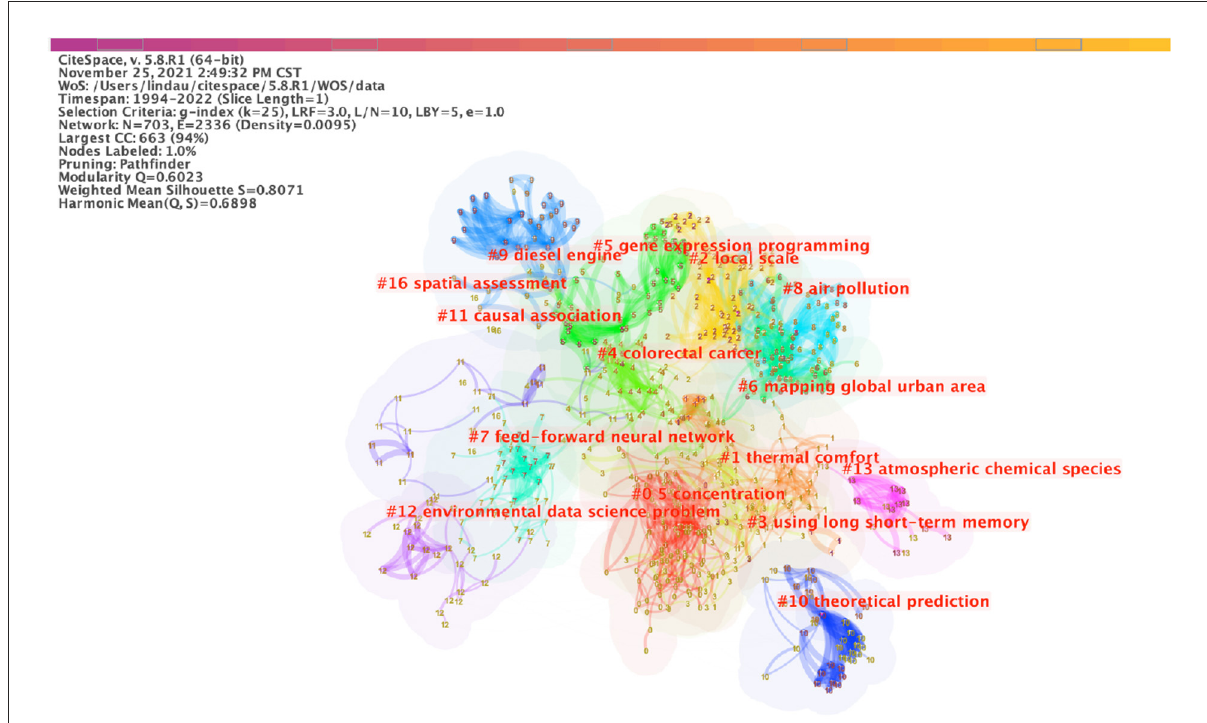
FIGURE2 Map of the occurrence of keywords. The nodes in the map represent keywords. The lines between the nodes represent co-occurrence relationships. The larger the node area, the higher the frequency. Each cluster was generated based on the number of keywords under one research domain, not the frequency of